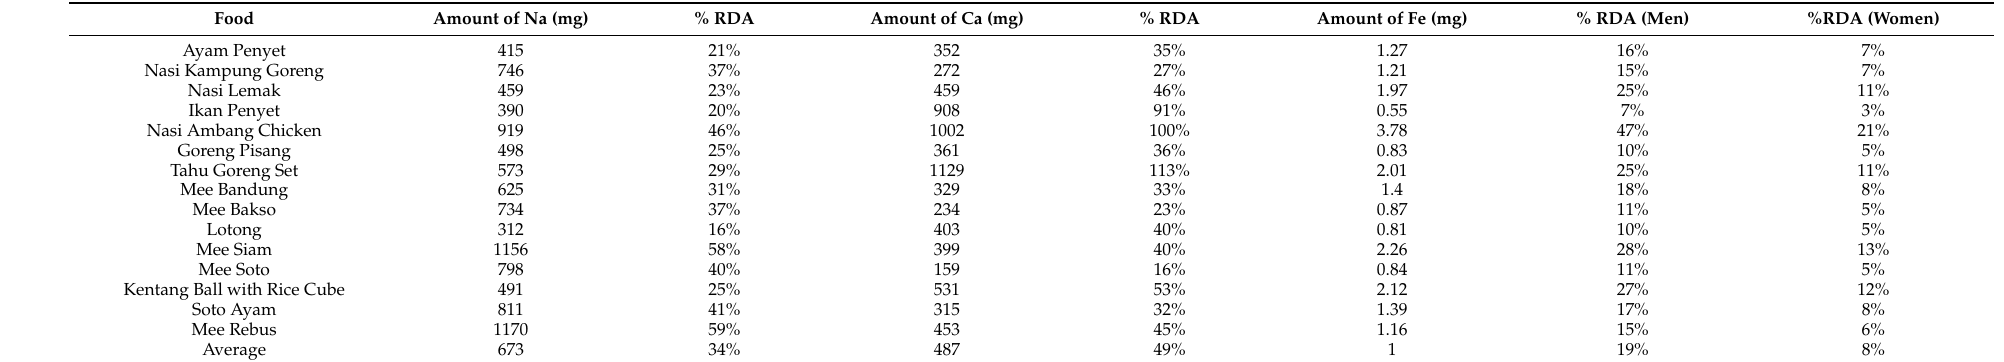
Table 8. Mineral content and the %RDA of the commonly consumed Malay cuisines.